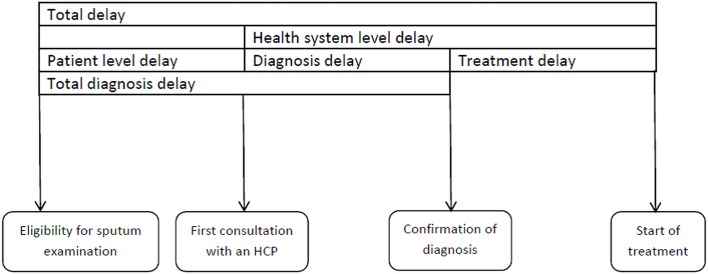
Conceptual framework on definitions of delay before treatment initiation among newly registered sputum postive TB patients, Axshya SAMVAD study, India (2016–17) * [28].* Reprinted with modification from Sreeramareddy CT et al [28] under a CC BY license, with permission from International Union Against Tuberculosis and Lung Disease (The Union), Copyright The Union 2014. SAMVAD–sensitization and advocacy in marginalised and vulnerable areas of the district. Axshya SAMVAD–an active case finding strategy under project Axshya implemented by The Union, South East Asia office, New Delhi, India, across 285 districts of India. HCP–Health Care Providers.